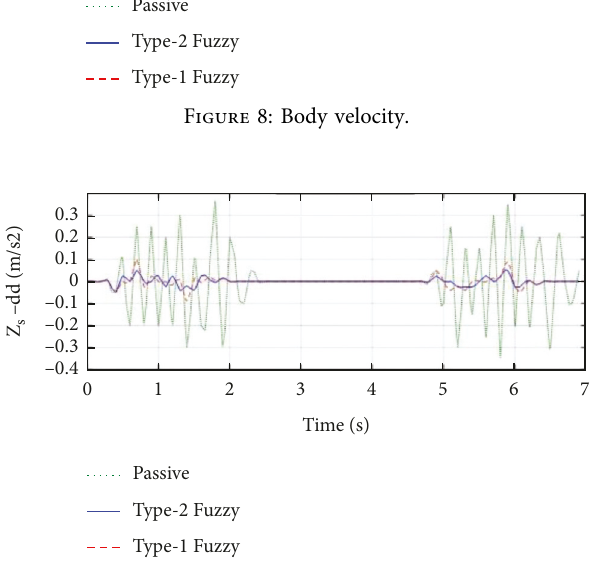
Figure 9: Body acceleration.